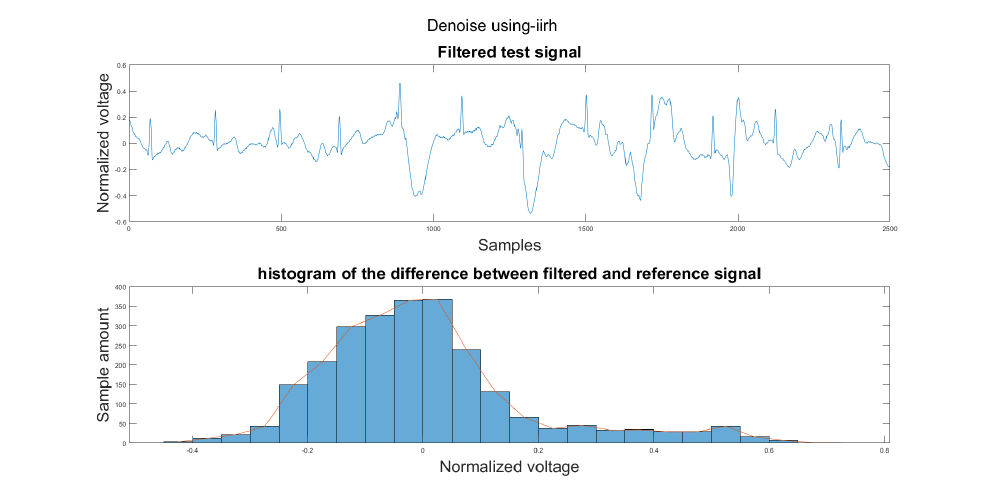
Figure A15. (1) Test signal, (2) histogram of the difference.